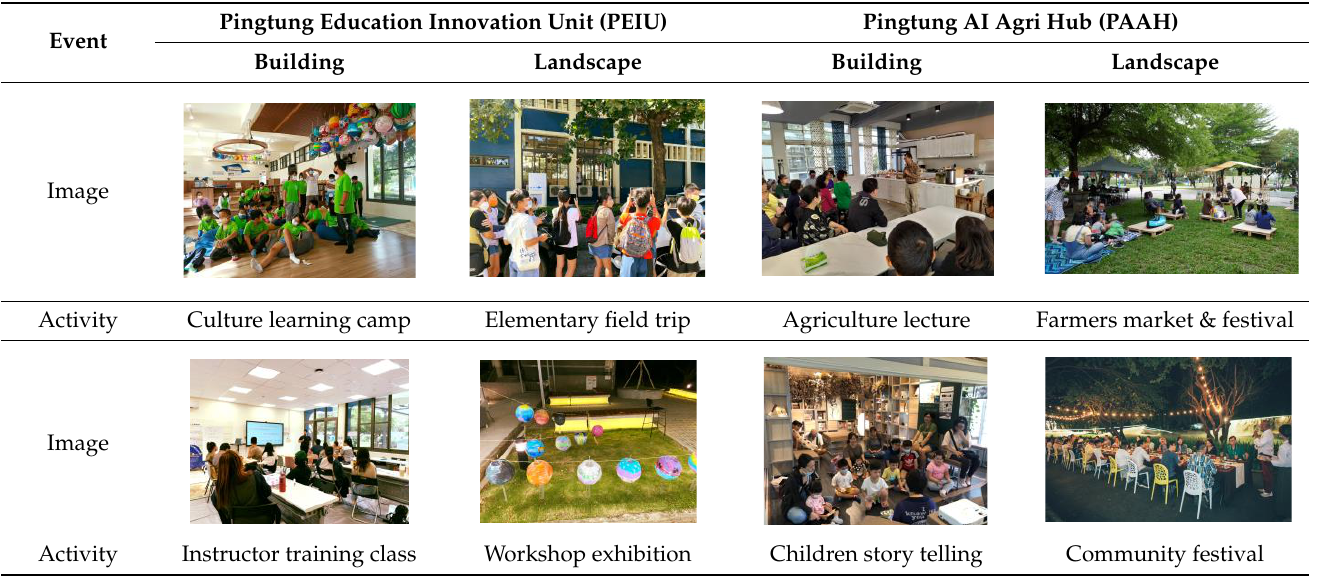
Table 6. Space Interaction of Campus Environment.